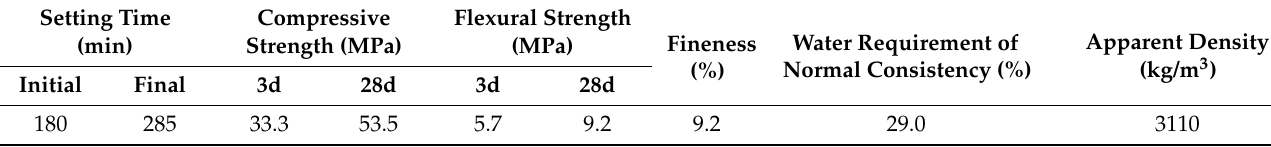
Table 1. Physical and mechanical properties of